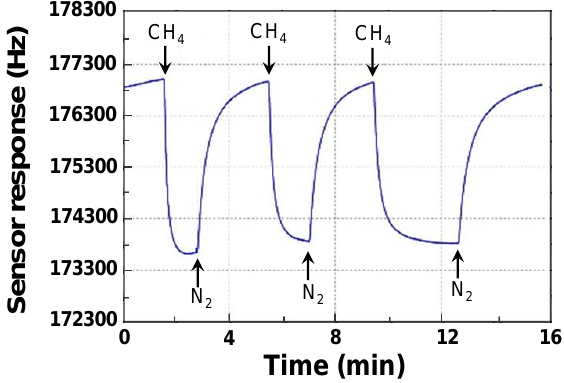
Figure 12. The repeatability test of the proposed sensor upon exposure to 5% CH 4.